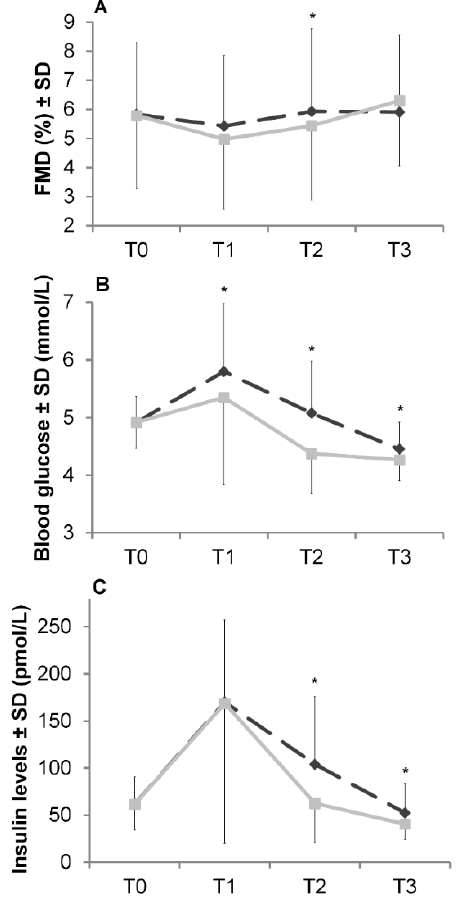
Figure 2. Basal (T0) and postprandial (T1–T3) FMD ( A ), blood glucose ( B ), and insulin levels ( C ) following the ingestion of isomaltulose ( ) and sucrose ( ). All values are reported as mean ± SD; T0 = 0 min, T1 = 60 min, T2 = 120 min, T3 = 180 min; * Significant difference between isomaltulose and sucrose; paired t test: p < 0.05.